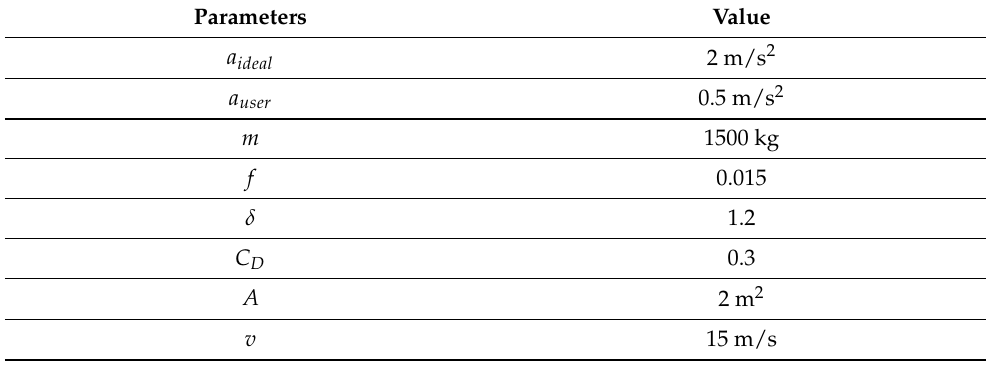
Table 1. Parameter settings in the driving experiment.